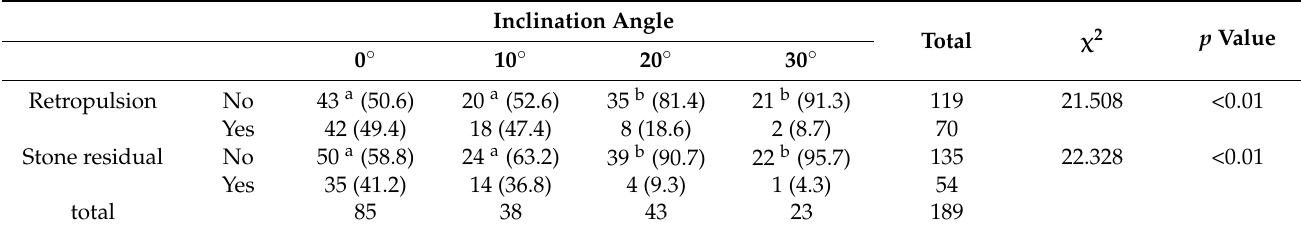
Table 2. Comparisons of stone retropulsion and stone-free rates between groups. Inclination Angle